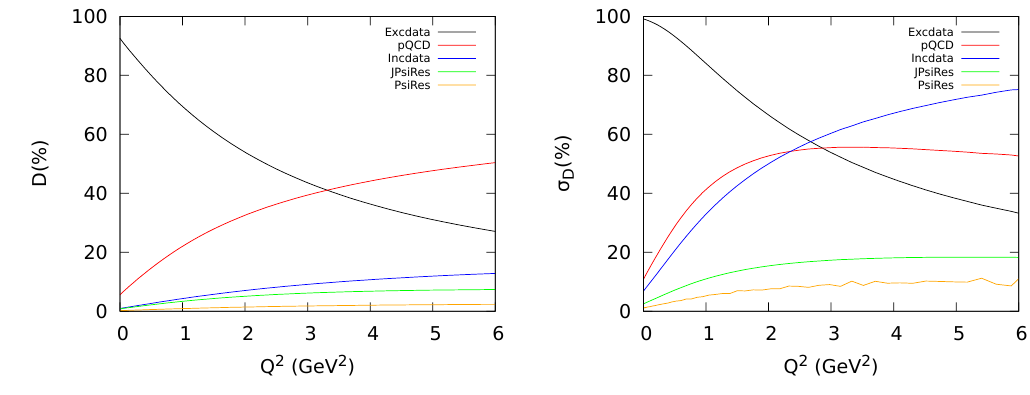
Figure 13 . Relative size of the different contributions to D ( Q 2 ) (left) and to their uncertain- ties (right) entering the data-driven dispersive evaluation based on the